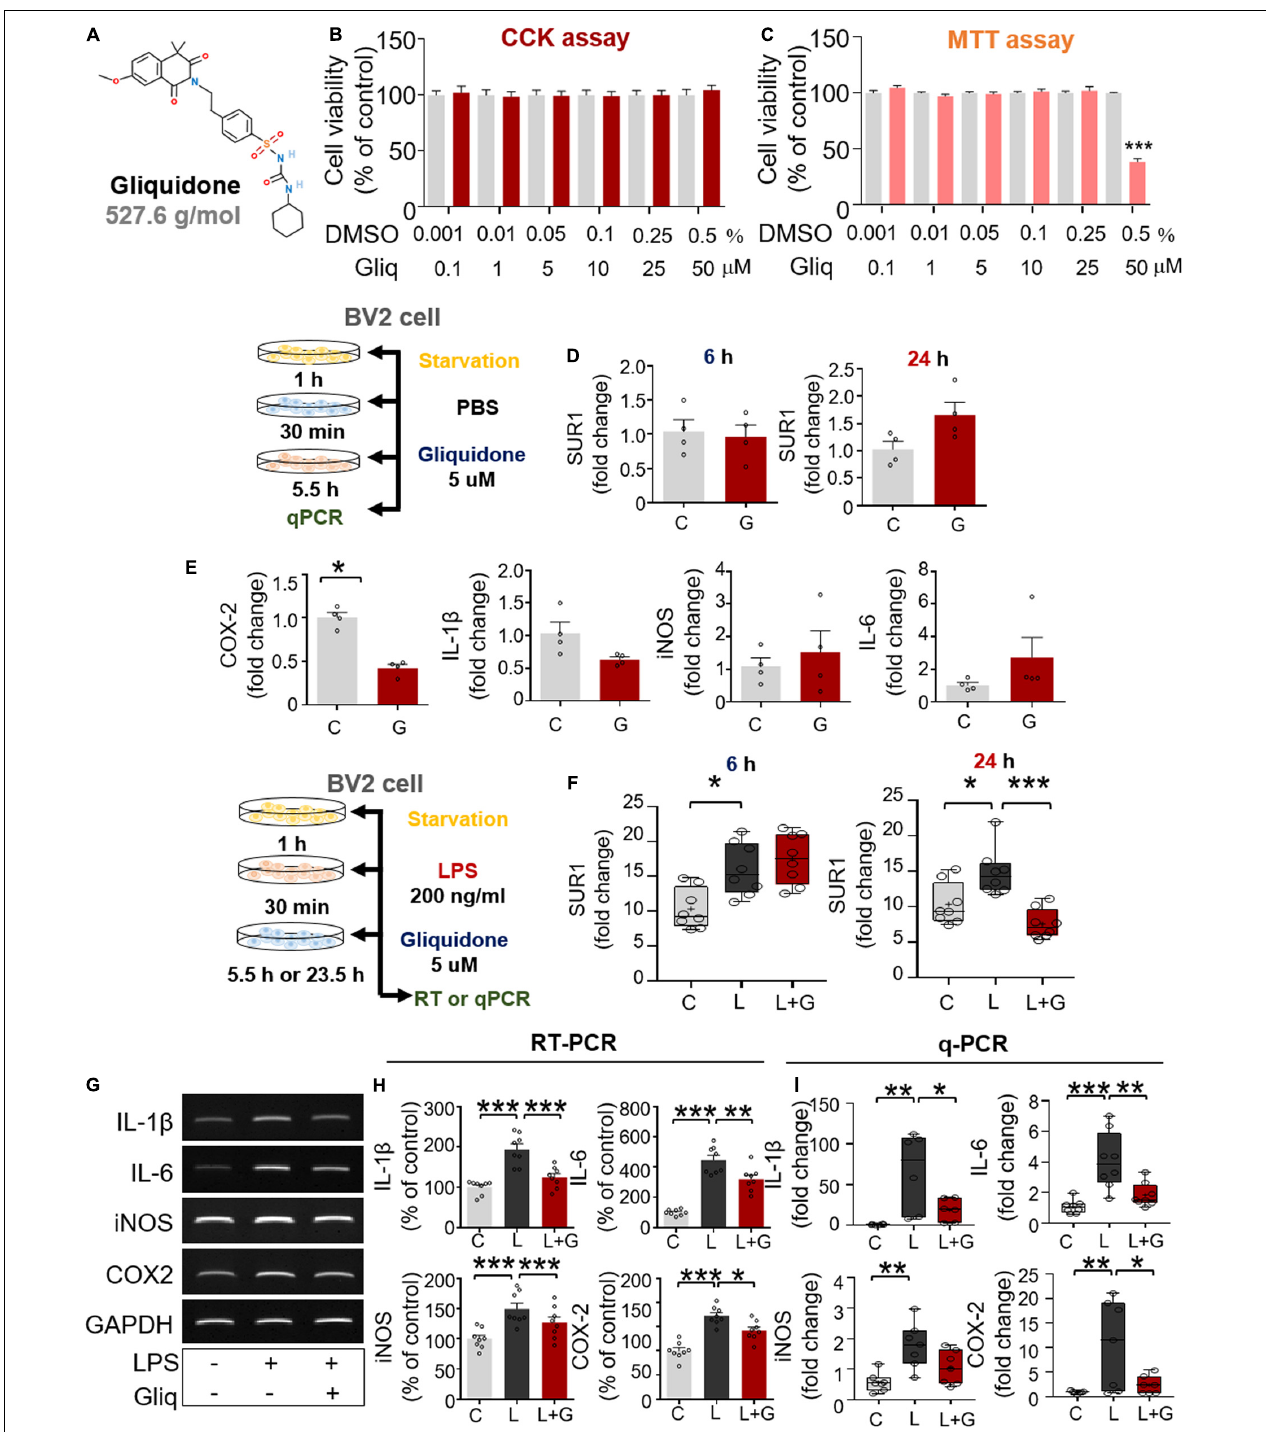
FIGURE 6 | Post-treatment with gliquidone reduces LPS-stimulated proinflammatory cytokine mRNA levels in BV2 microglial cells. (A) Structure of gliquidone. (B,C) CCK and MTT assays were conducted after treating cells with gliquidone at the indicated doses or with vehicle for 6 or 24 h (CCK: 6 h, n = 16/dose; MTT: 24 h, n = 17/dose). (D) SUR1 mRNA levels in cells treated for 6 or 24 h with gliquidone alone or vehicle, as determined by q-PCR ( n = 4/group). (E) Proinflammatory cytokine mRNA levels in cells treated with gliquidone alone or vehicle for 6 h, as determined by q-PCR ( n = 4/group). (F) Real time-PCR (q-PCR) analysis of SUR1 mRNA levels in cells treated sequentially with LPS for 30 min and gliquidone for 5.5 or 23.5 h ( n = 8/group). (G,H) RT-PCR analysis of proinflammatory cytokine levels in cells treated sequentially with LPS and gliquidone ( n = 8/group). (I) Real time-PCR (q-PCR) analysis of proinflammatory cytokine levels in cells treated sequentially with LPS and gliquidone (IL-1 β , n = 6/group; IL-6, n = 8/group; iNOS, n = 7/group; COX-2, n = 7/group). * p < 0.05, ** p < 0.01, *** p < 0.001.